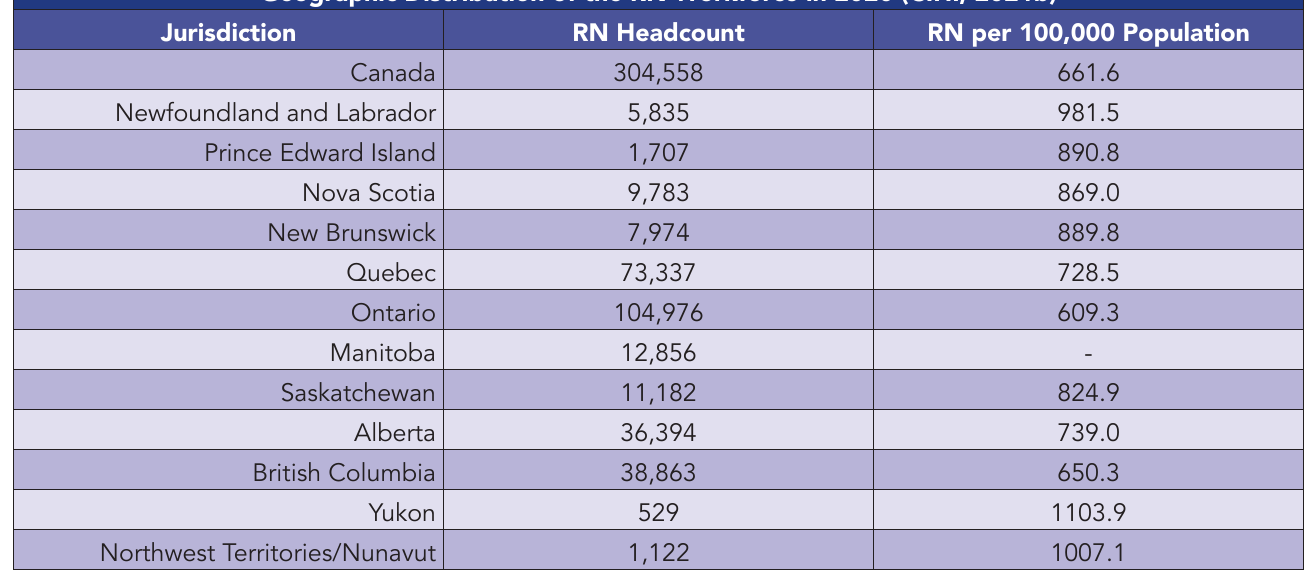
Table 3. The geographic distribution of the RN workforce in 2020 Geographic Distribution of the RN Workforce in 2020 (CIHI, 2021b)